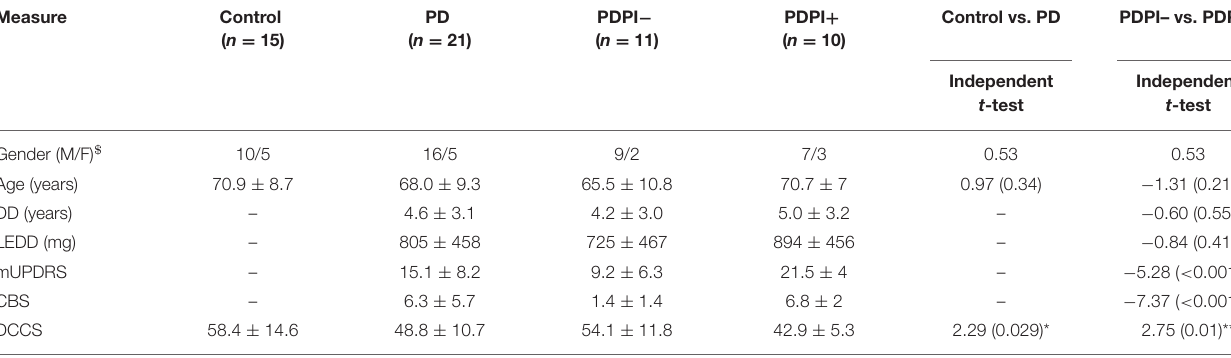
TABLE 1 | Demographic and clinical